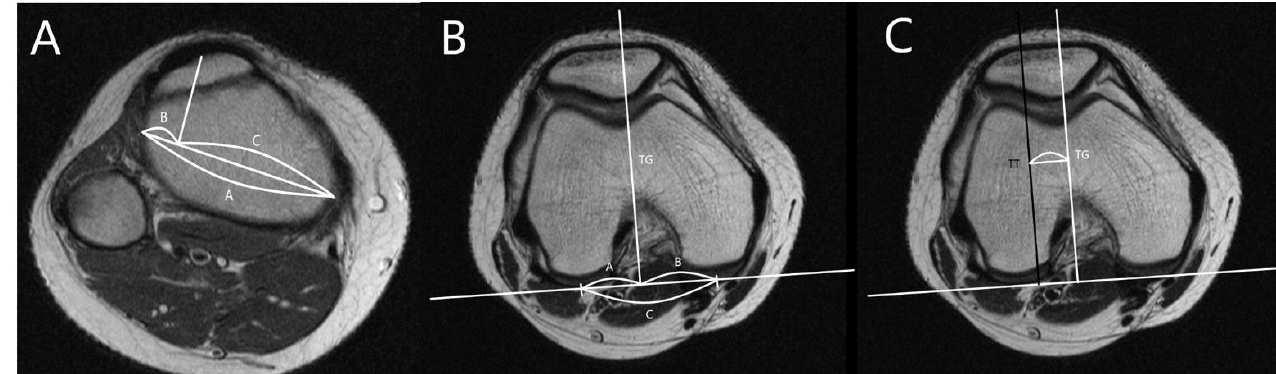
Figure 3. Position of the trochlear groove and tibial tuberosity. ( A ) Measurement of percent tibial tuberosity location (PTL). Lines B and C are divided by perpendicular lines from tibial tuberosity to line A [B/A × 100]. ( B ) Measurement of percent sulcus location (PSL). Lines E and F are divided by perpendicular lines from the deepest portion of the trochlear groove to a line along with posterior aspects of femoral condyles [E/D × 100]. ( C ) Measurement of tibial tuberosity—trochlear groove (TT-TG) distance, the distance from the deepest point of the trochlear groove to the tibial tuberosity.